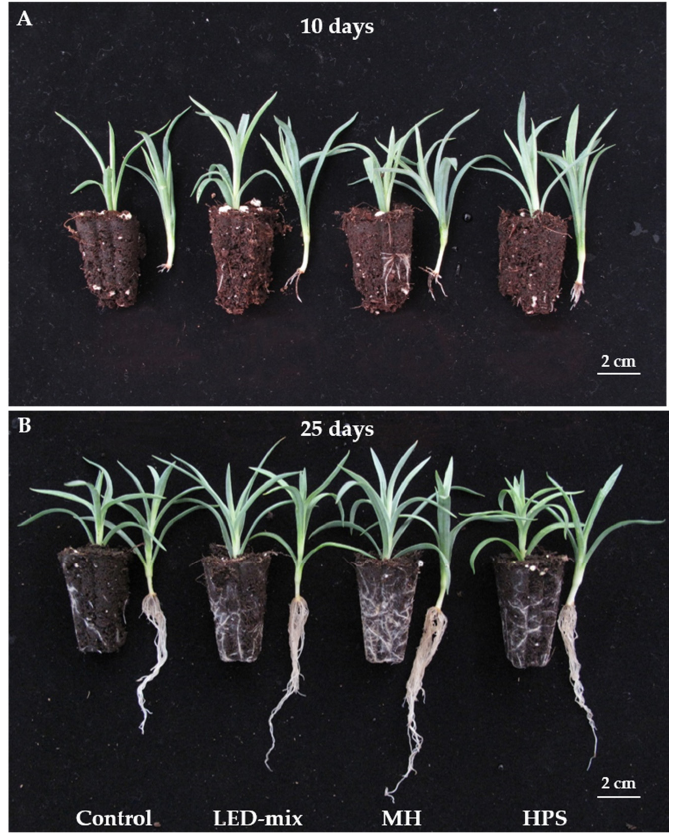
Figure 2. The morphology of carnation ‘Dreambyul’ cuttings affected by the supplementary light source after 10 ( A ) and 25 days ( B ) of propagation.